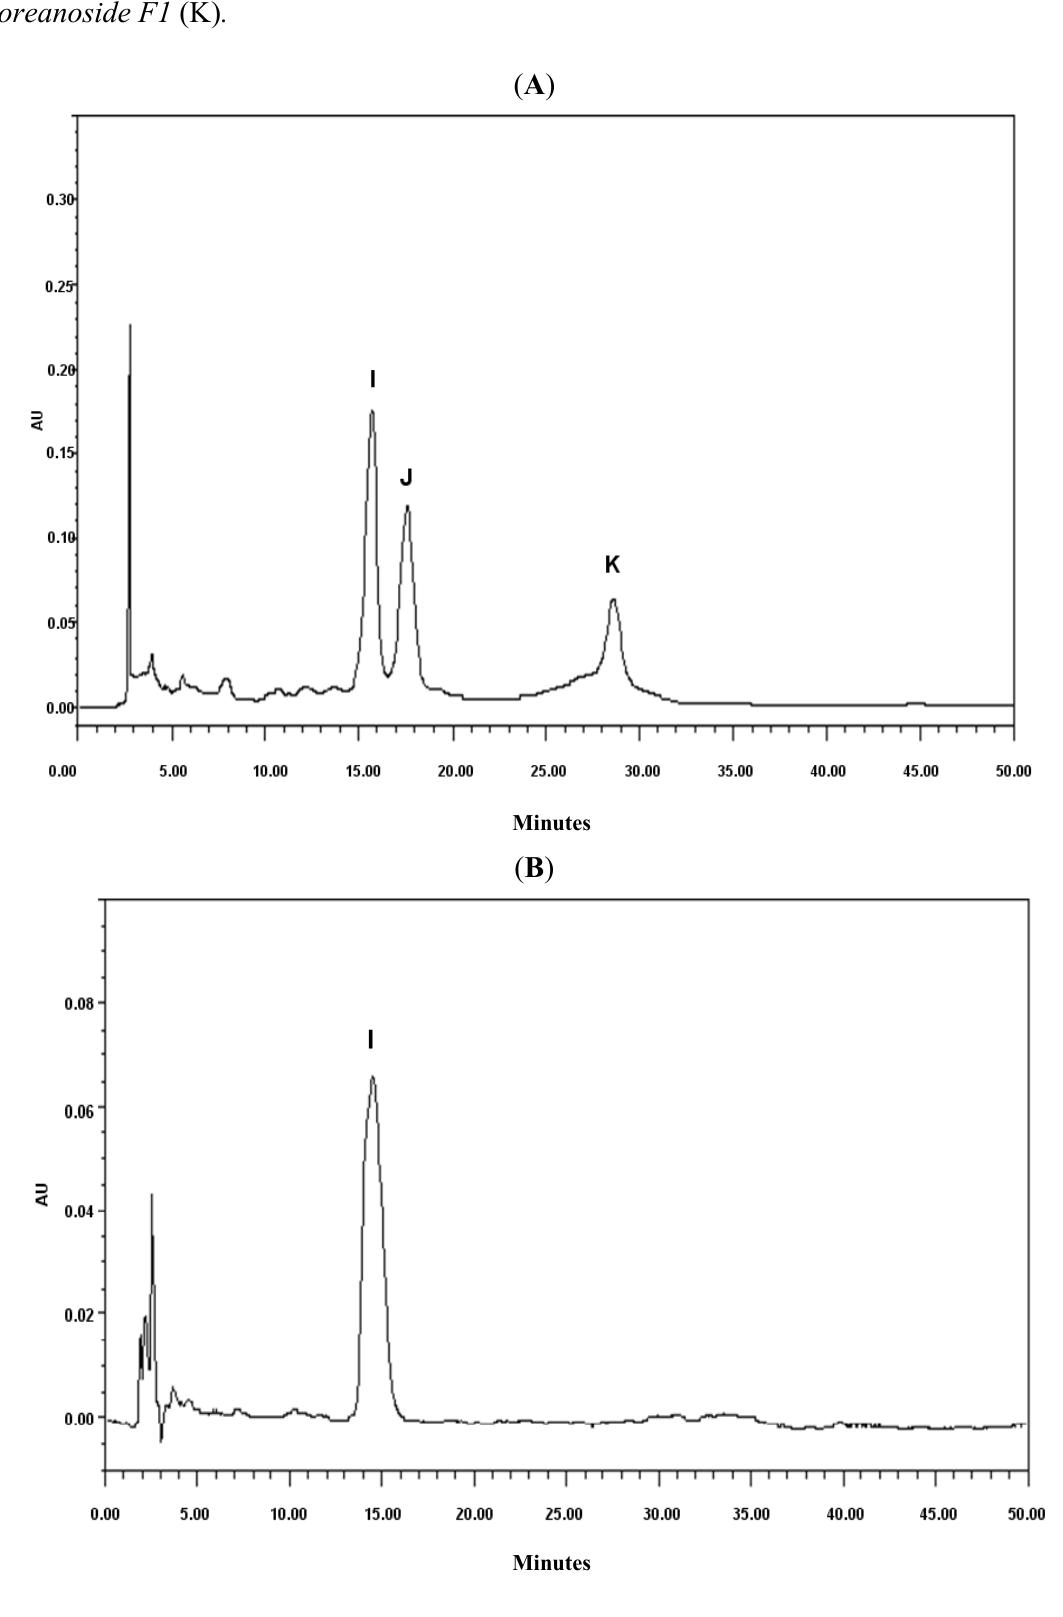
). ( C ) Chemical 1 (I) suavissimoside R (J). ( D ) Chemical structure of 1 1